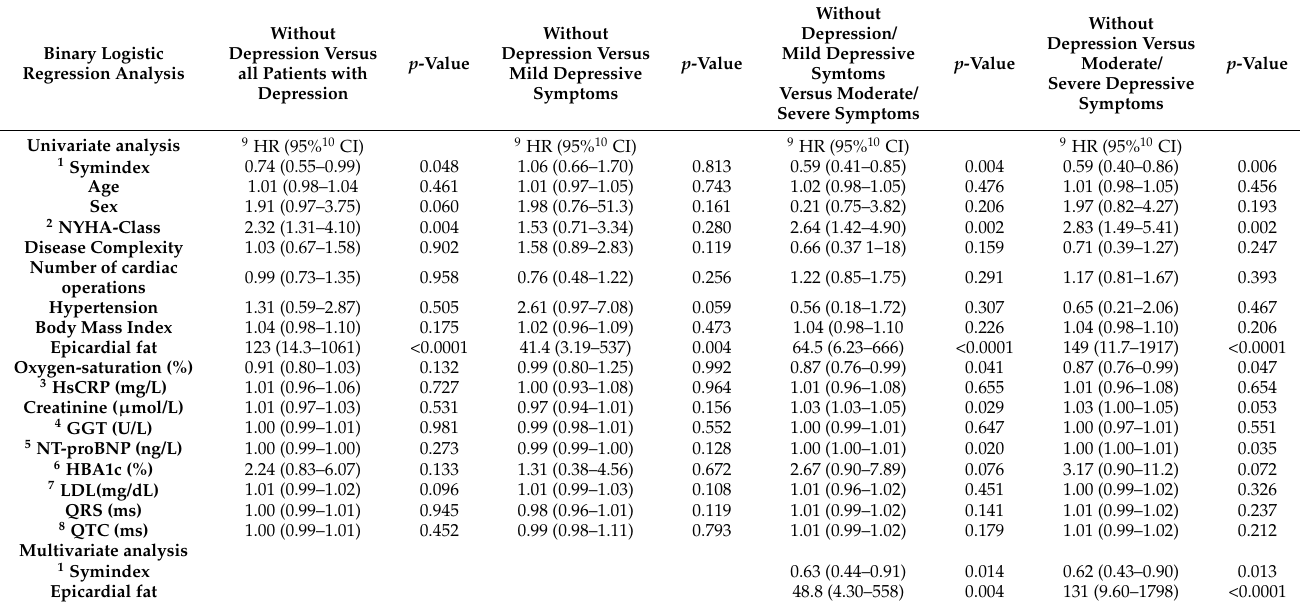
Table 3. Predictors of moderate/severe depression. Univariate binary regression analysis of baseline clinical characteristics identified single predictors of depression. Multivariate analysis included all parameters with a significance level <0.08. In multivariate analysis, Symindex and epicardial fat remained as the only independent predictors of moderate/severe depression. Mild depression was not associated with reduced heart rate